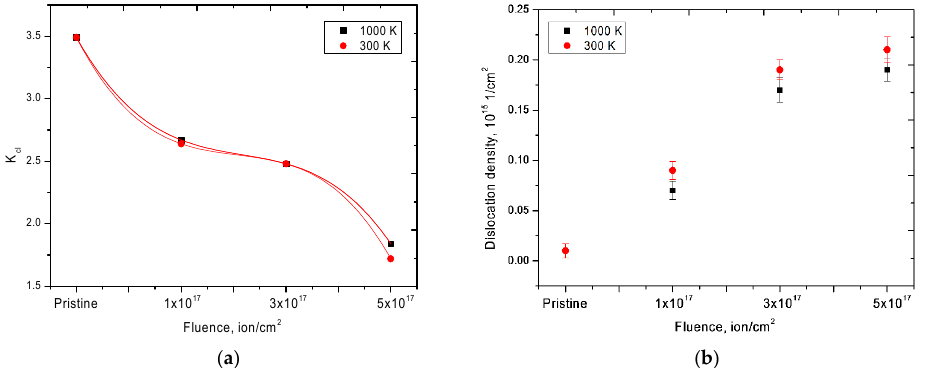
Figure 6. ( a ) Dynamics of change in the Griffith criterion; ( b ) graph of changes in the density of dislocations as a result of irradiation.